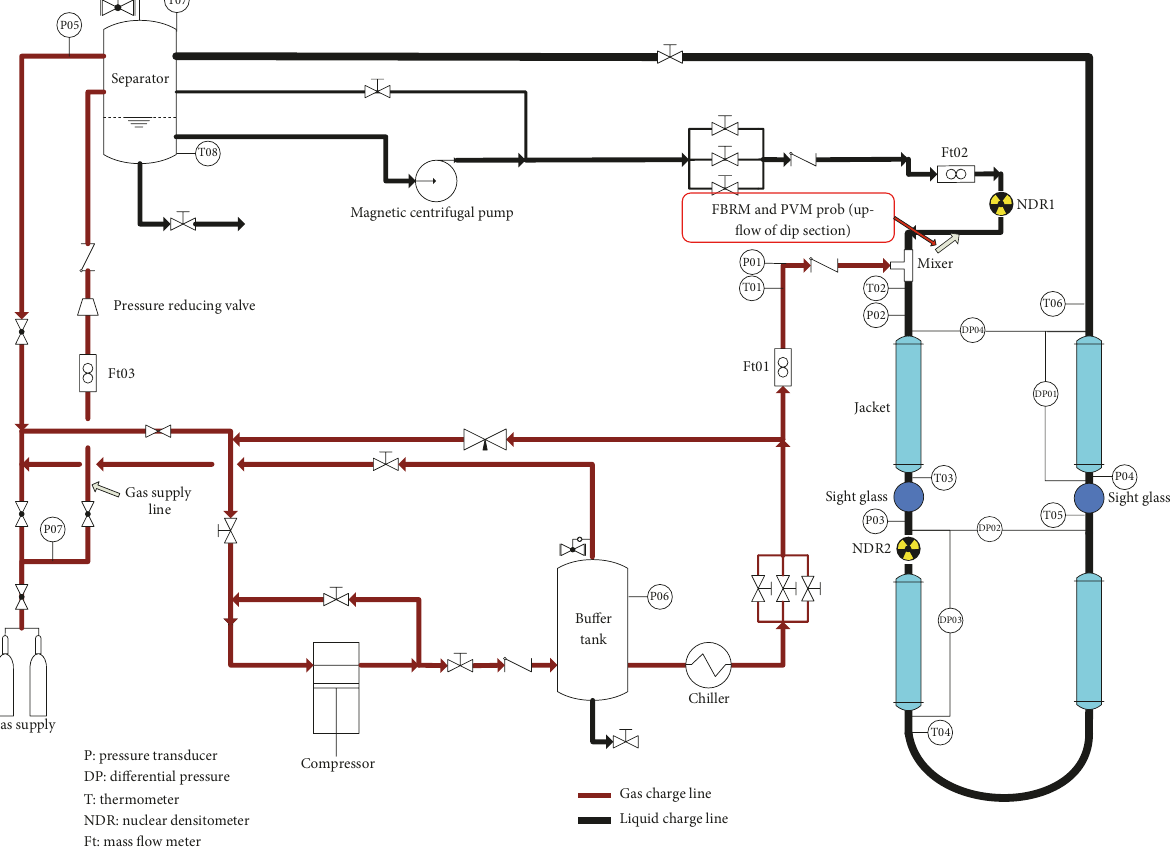
Figure 2: Sketch of high-pressure hydrate flow